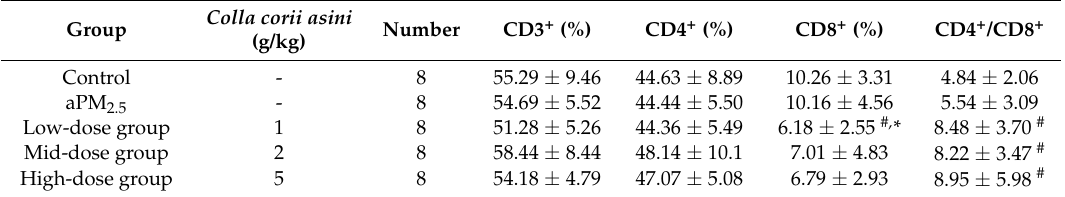
Table 1. Role of Colla corii asini in aPM 2.5 -induced alteration of T lymphocyte subsets. Colla corii asini (g/kg) Group Number CD3 + (%) Control Mid-dose group High-dose group Data are presented as the mean ± SD. # p < 0.05, significant difference between Colla corii asini -treated groups and control group; * p < 0.05, significant difference between Colla corii asini -treated groups and aPM 2.5 -treated group.